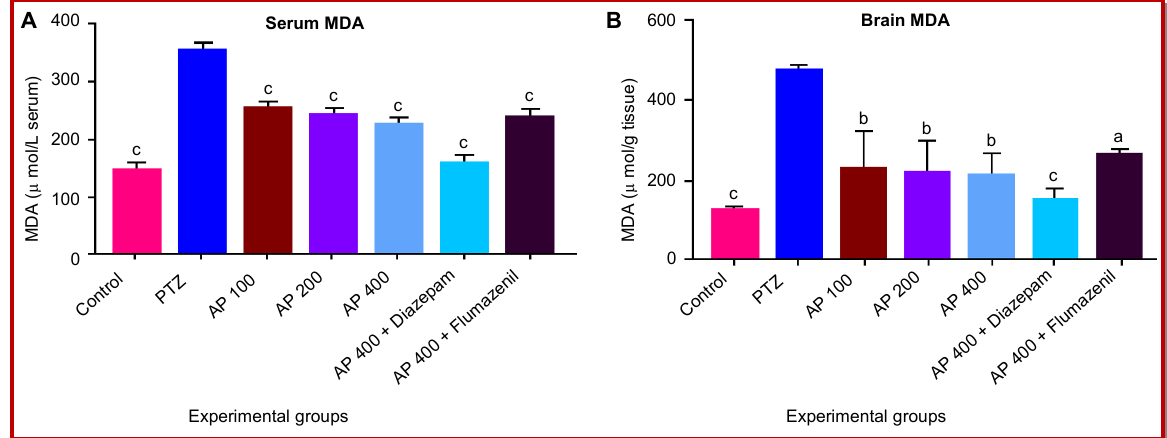
Figure 5: Comparison of serum (A) and brain (B) malondialdehyde levels between groups; * significant difference compared to pentylenetetrazole group ( a p<0.05, b p<0.01 and c p<0.001); AP = A.